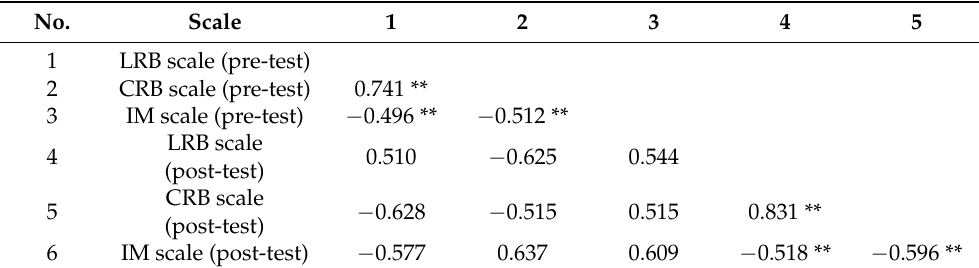
Table 3. Correlation for all variables used in these analyses.